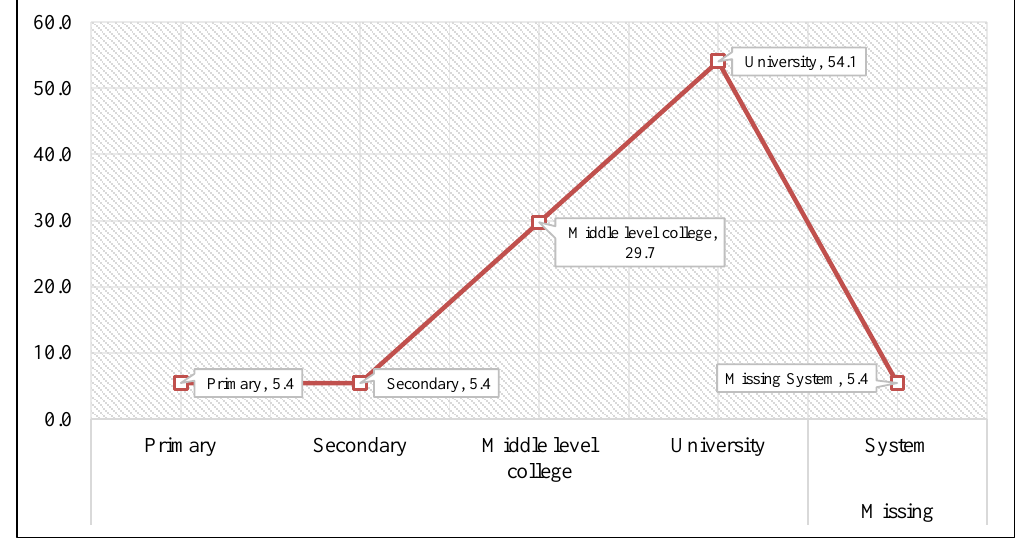
Figure 4. Education level